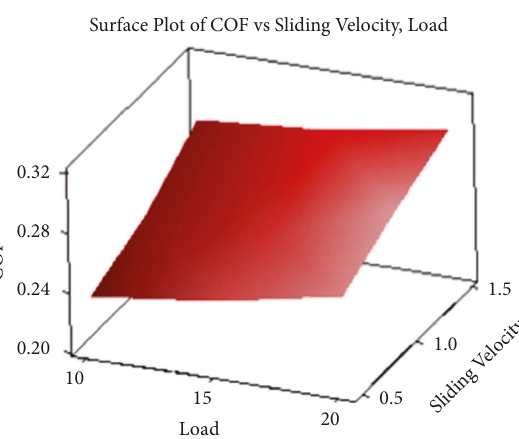
Figure 9: Surface plot graph for load % vs sliding distance to